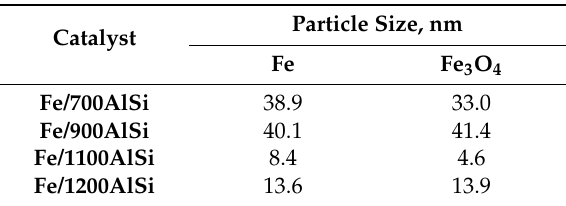
Figure 2. X-ray diffraction (XRD) results for different support calcination temperatures of ( a ) reduced and ( b ) carbided catalysts. The catalysts reduced in H 2 at 320 °C for 16 h and then passivated in 1% O 2 in He. The passivated reduced catalysts were carbided at 280 °C in H 2 /CO = 1. Table 2. Crystallite size of reduced catalysts calculated from XRD.